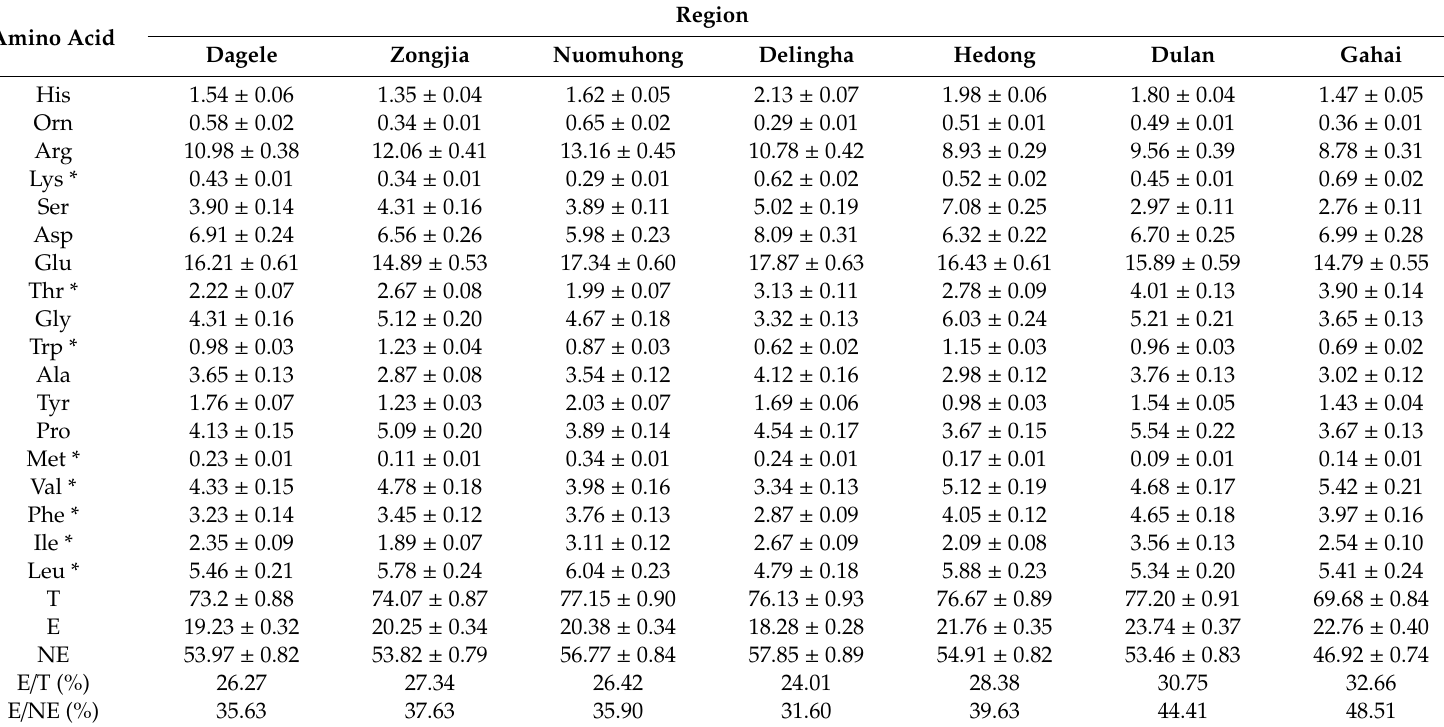
Table 3. The measured contents of amino acids in seeds of Nitraria tangutorum Bobr. (mg / g). Amino Acid